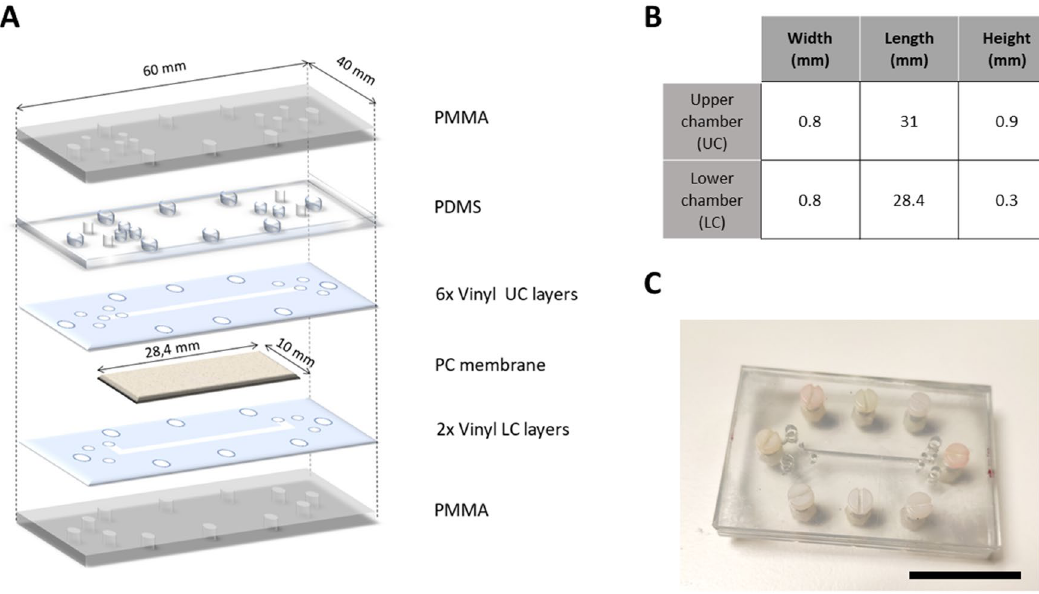
Figure 2. ( A ) Assembly of the chip with its different layers. ( B ) Table with the dimensions of the chambers of the chip. See also Fig. S1. ( C ) Real picture of the assembled chip. Scale bar: 3